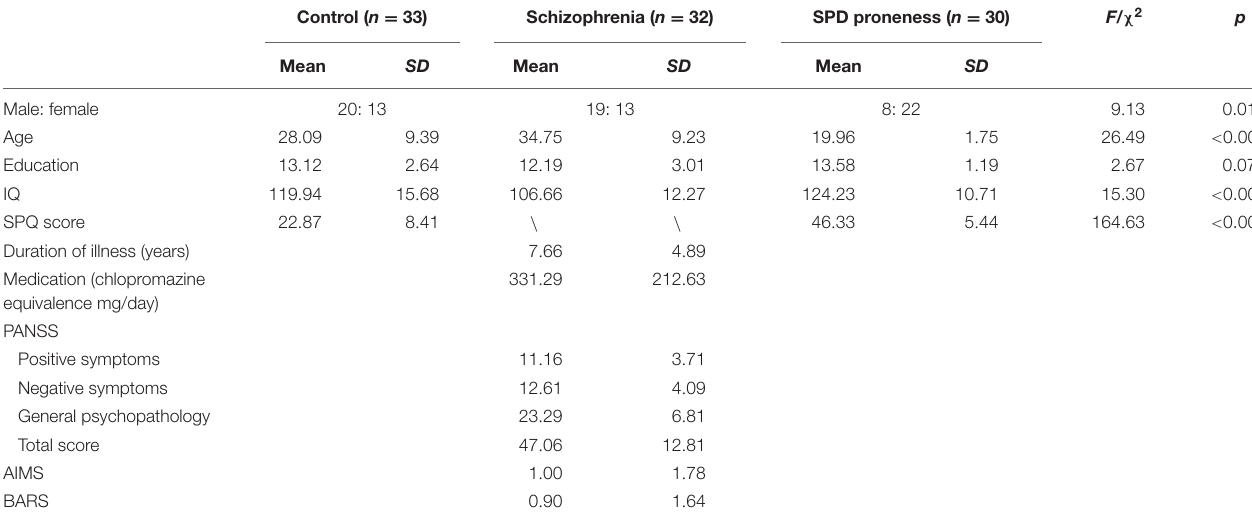
TABLE 1 | Demographic information of participants.